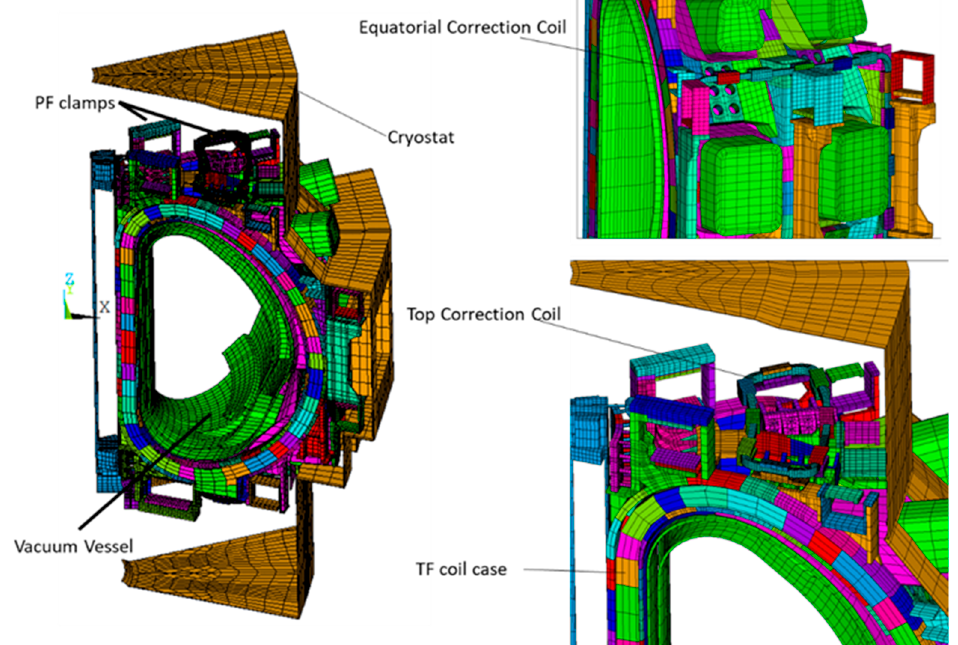
Figure 9. Testcase#1 TF magnet system structure.